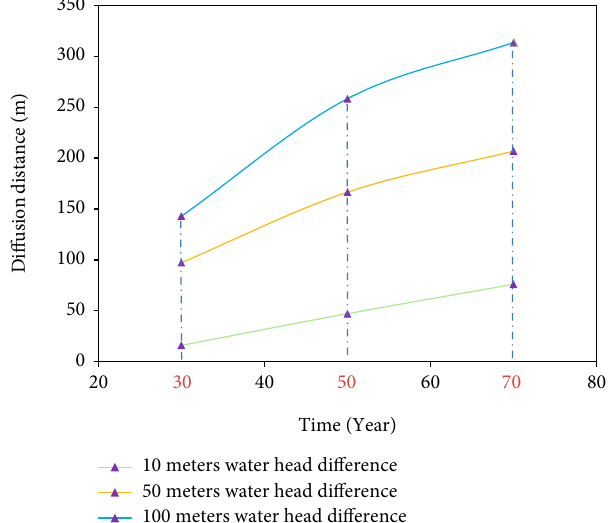
Figure 15: Comparison of the di ff usion distance of concentrated brine to the north side at di ff erent groundwater head di ff erences under long-term penetration